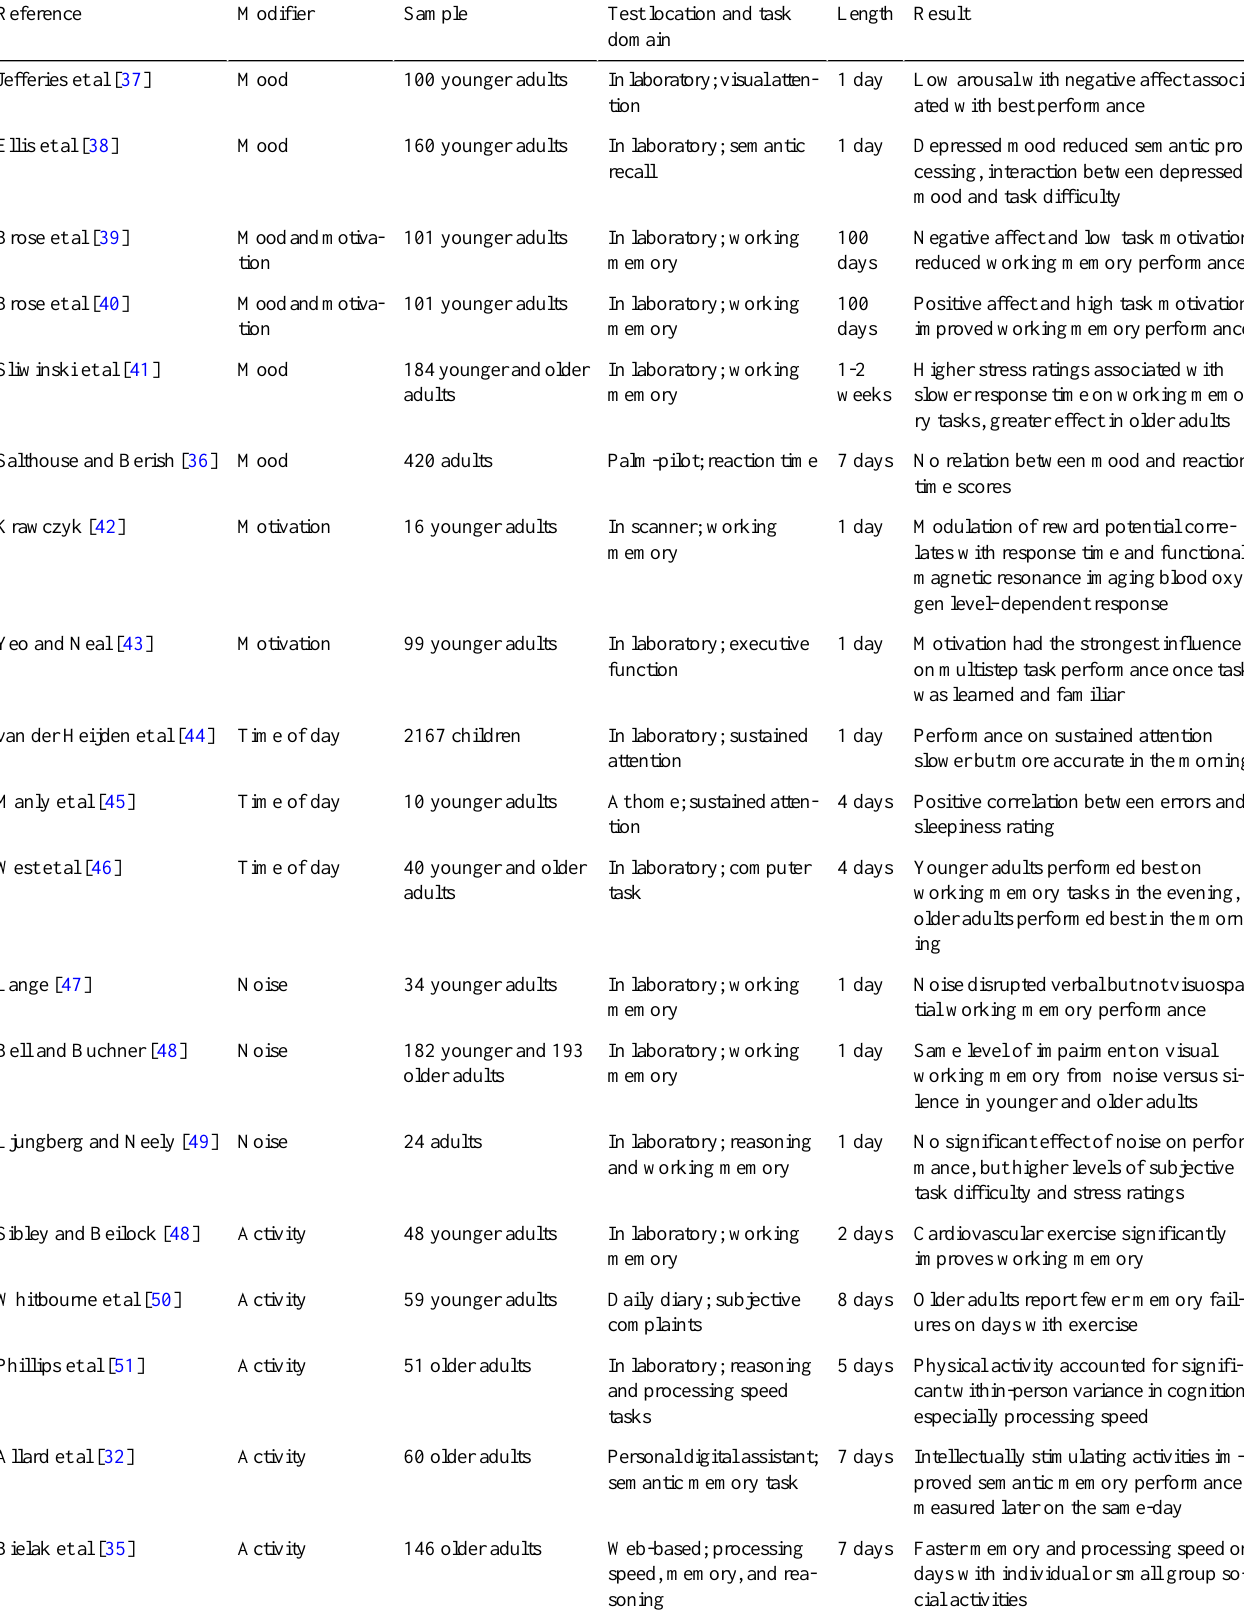
Table 1. Internal and external modifiers of cognitive